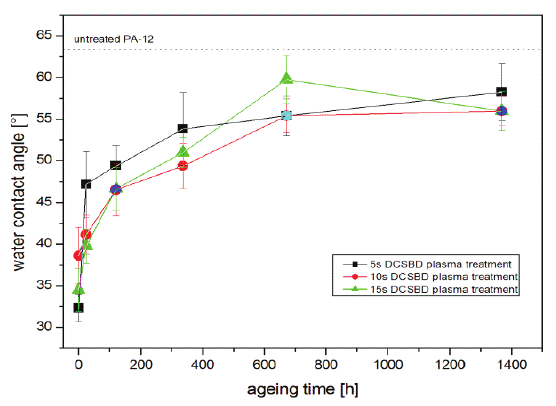
Figure 3: Ageing effect of PA-12 wettability for DCSBD surface modification.